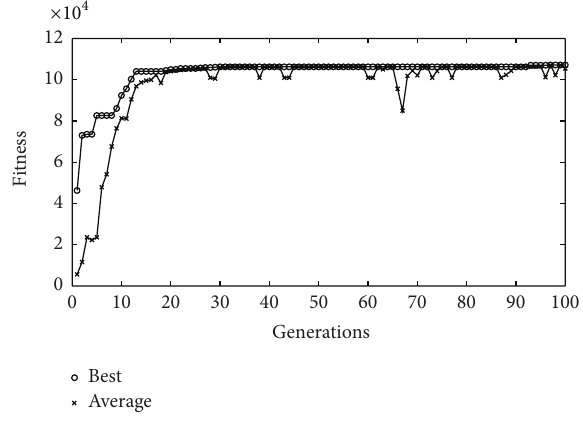
Figure 4: Convergence of fitness in